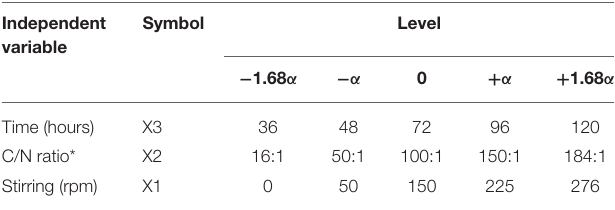
TABLE 1 | Coded values of independent variables at different levels used in Central Composite Design. Independent